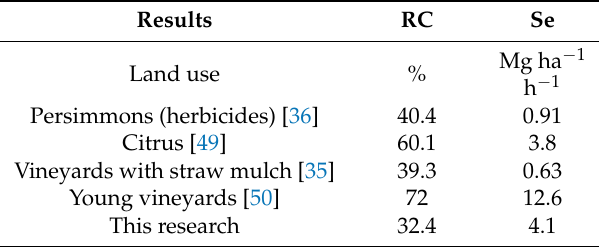
Table 3. Comparison of runoff coefficients (RC) and soil erosion rates (Se) with other studied land uses in the Valencia region using the same rainfall